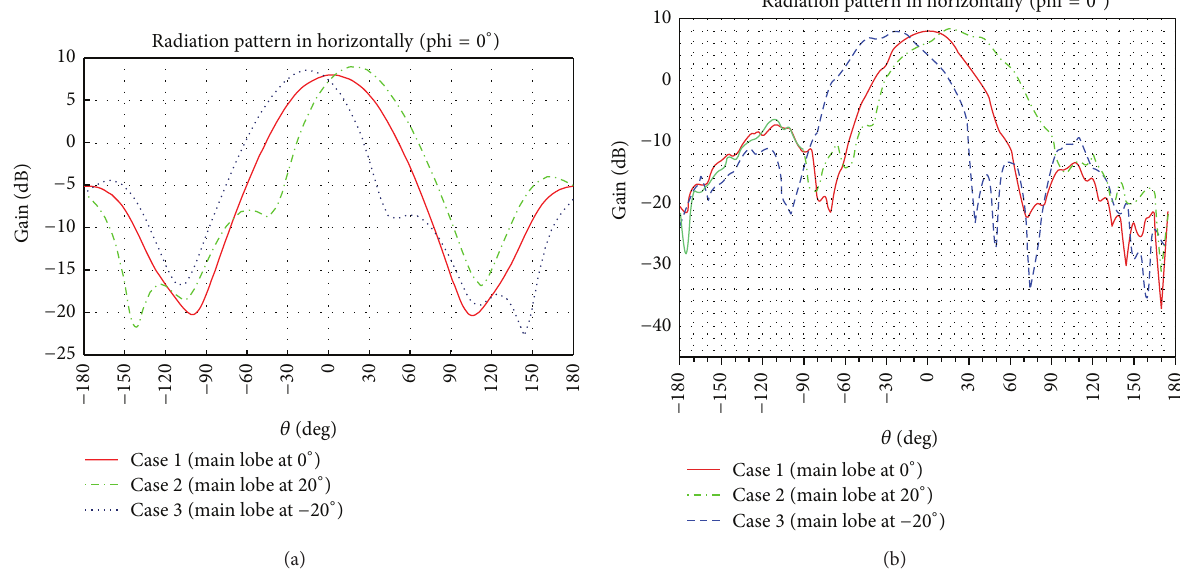
Figure 25: (a) Radiation pattern of beam steering RA in simulation. Beam steering horizontally; steering angles: − 20 ∘ (case 2), 0 ∘ (case 1), and 20 ∘ (case 3). (b) Radiation pattern of beam steering RA in measurement. Beam steering horizontally; steering angles: − 20 ∘ (case 2), 0 ∘ (case 1), and 20 ∘ (case